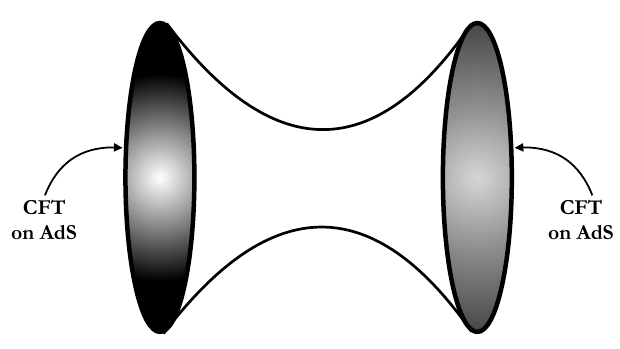
Figure 1 . A wormhole connecting two UV